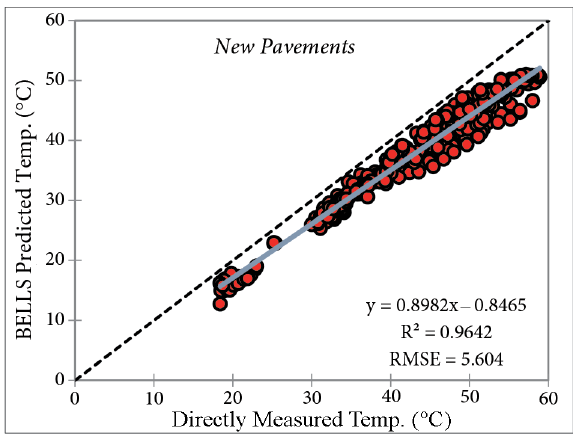
Figure 8. BELLS predicted versus directly measured temperatures in new pavements